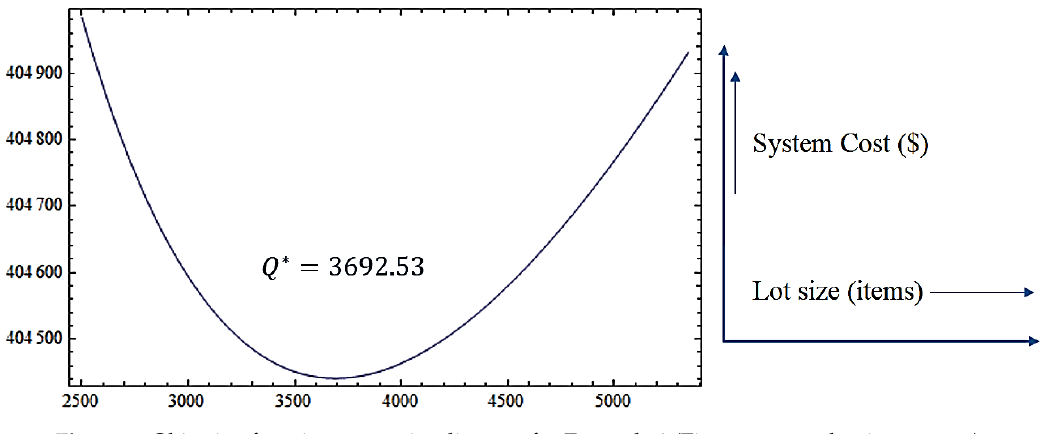
Figure 6. Objective function convexity diagram for Example 1 (Five-stage production system).